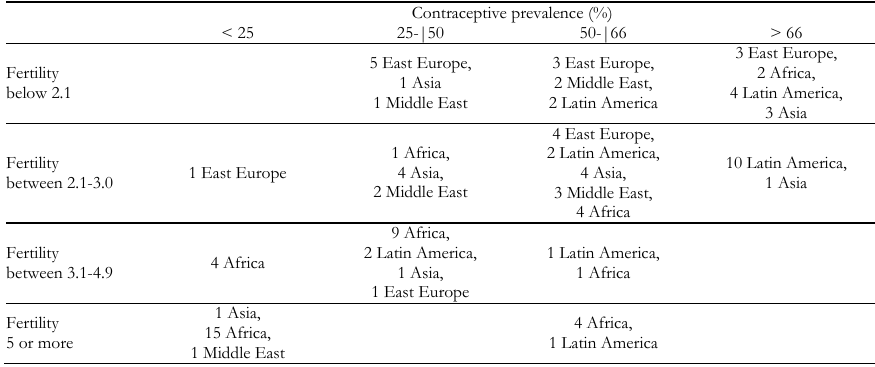
Fertility levels and contraceptive prevalence by major area, 2007 Contraceptive prevalence (%) < 25 25-|50 >